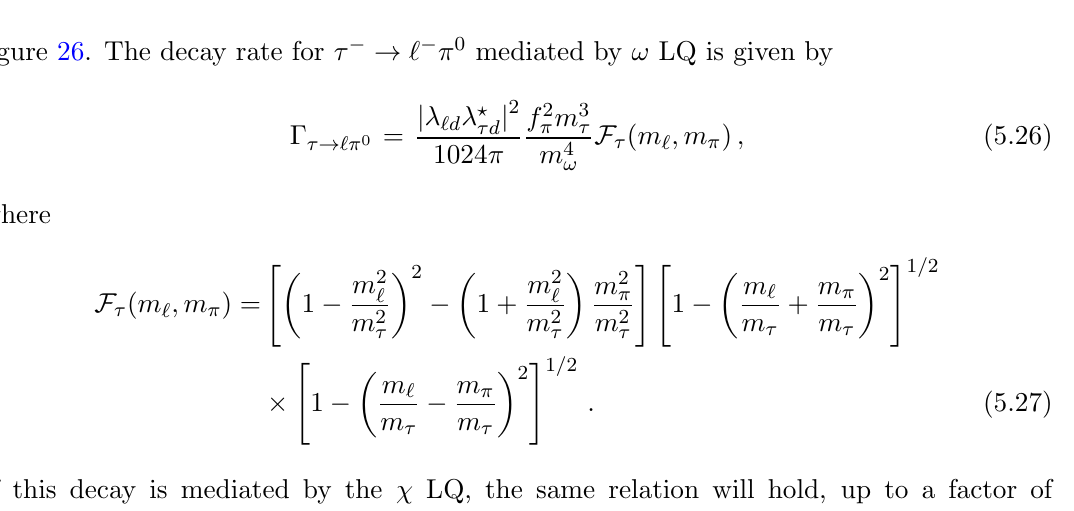
(cid:22)(cid:25) 0 ( (cid:22)(cid:17) , (cid:22)(cid:17) 0 ) and (cid:28) !